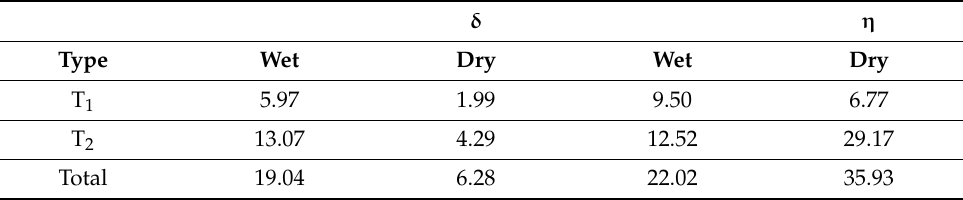
Table 1. Total amount of water stored to be evaporated ( δ , mm) and water absorbed by plants ( η , mm) during the wet (Wet) and dry (Dry) seasons. Data are given in mm according to the type of precipitation event (T 1 and T 2 ; see details in Materials and